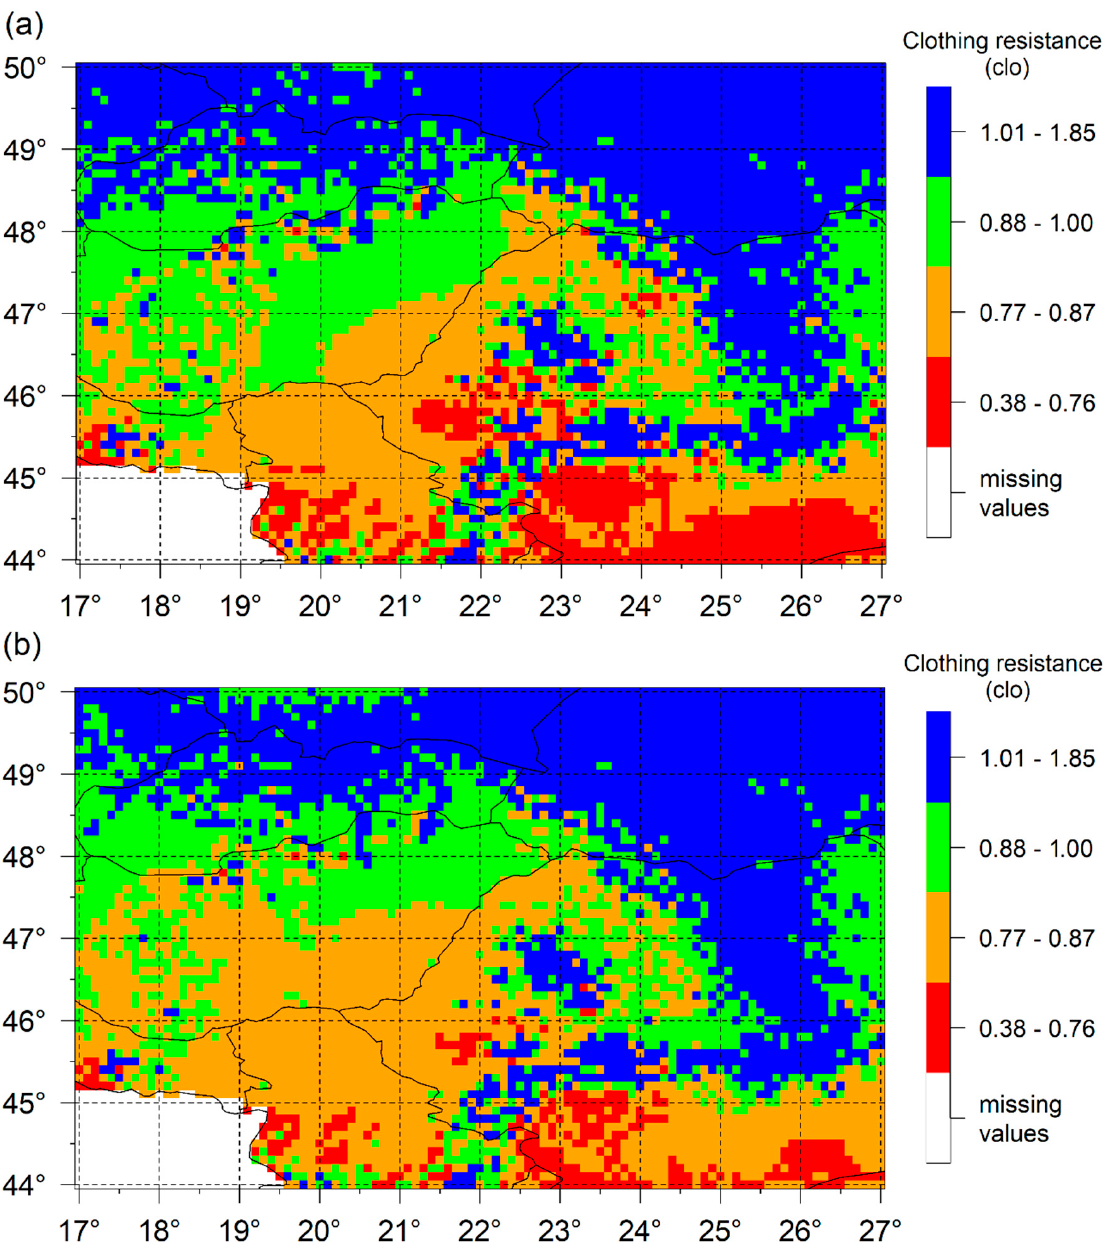
Figure 7. Spatial distribution of clothing thermal resistance values for year obtained by calculating operative temperature by using deterministic ( a ) and by statistical deterministic ( b ) procedures for person 2 representing the average adult Hungarian female in the CarpatClim dataset region for the period 1971–2000.